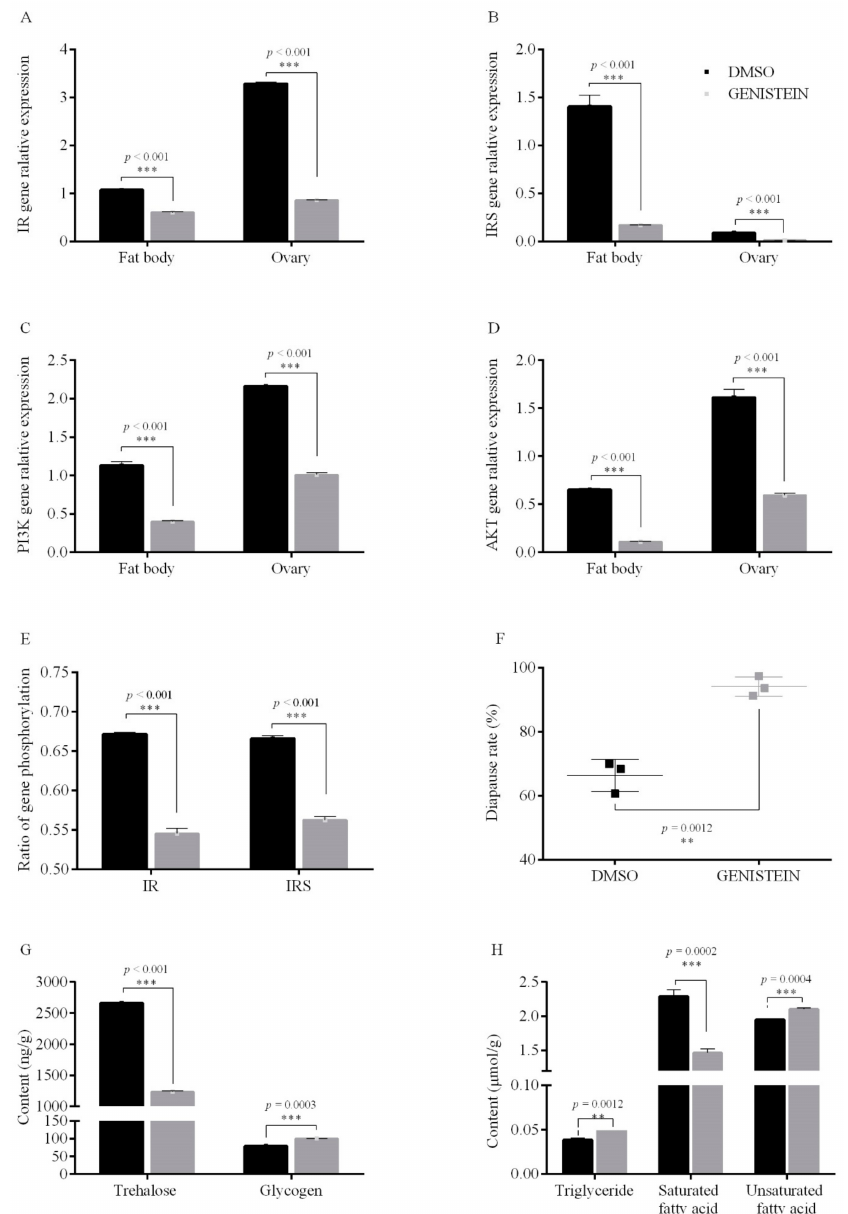
Figure 4. Gene relative expression, phosphorylation level, energy metabolism and egg diapause incidence after injection of adults with the PTK inhibitor genistein compared to DMSO (control) under short photoperiod conditions (L10: D14). ( A ) IR gene, ( B ) IR S gene, ( C ) PI3K gene, ( D ) AKT gene in the fat bodies and ovaries, ( E ) phosphorylation levels of IR and IRS in the 10-day-old eggs, ( F ) egg diapause incidence, ( G , H ) energy metabolism in the 10-day-old eggs. Data are the mean ± SEM from three independent replicates, the gray bar indicates PTK inhibitor treatments, while the black bar indicates DMSO controls (** p < 0.01 and *** p < 0.001 vs. DMSO controls as assessed, Student’s t